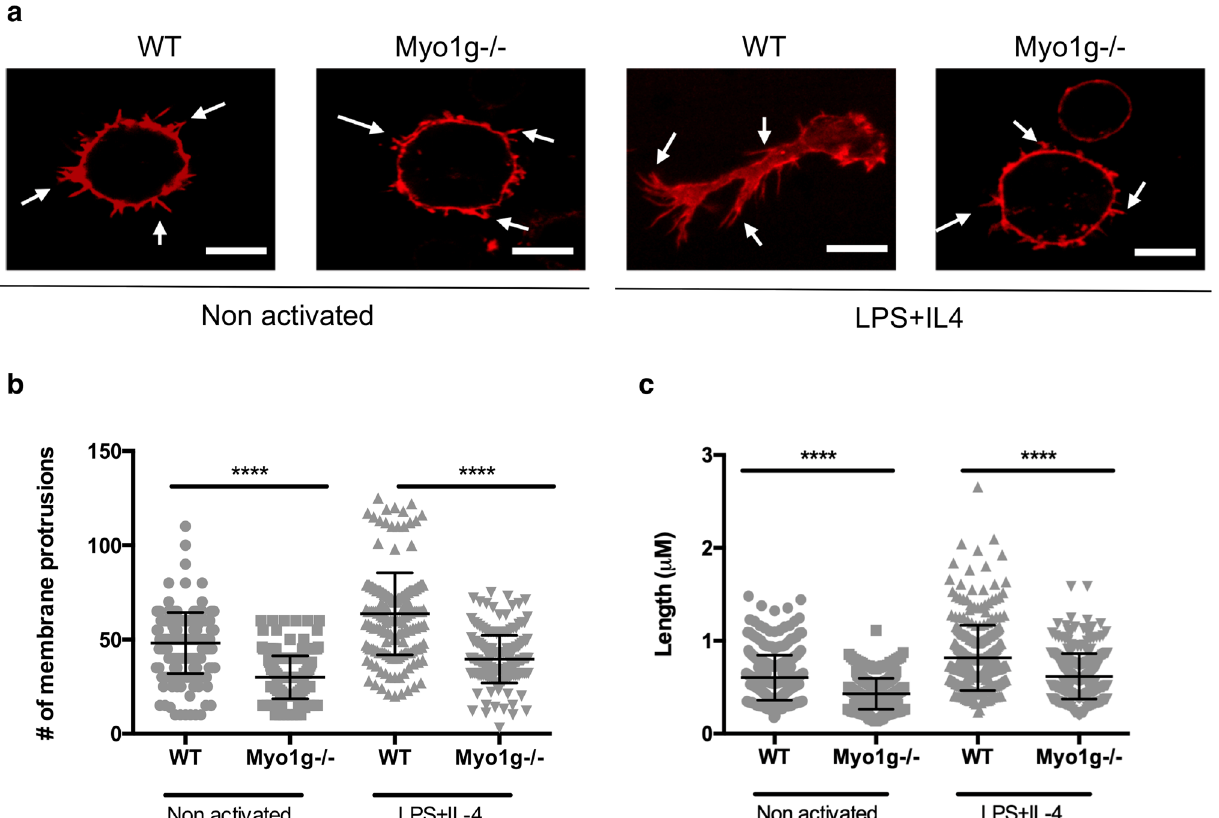
Figure 5. Myo1g participates in the ability of B lymphocytes to generate membrane protrusions. ( a ) Representative images (63 × objective) of non-activated or LPS + IL-4 activated WT and Myo1g −/− B lymphocytes incubated two hours on Fibronectin-covered coverslips. Cells were stained with Tritc-Phalloidin, and membrane protrusions are indicated with white arrows. Scale bars 5 μm. n = 3. ( b ) The number of membrane protrusions and ( c ) their lengths were measured on at least 50 activated B lymphocytes of WT and Myo1g −/− mice in